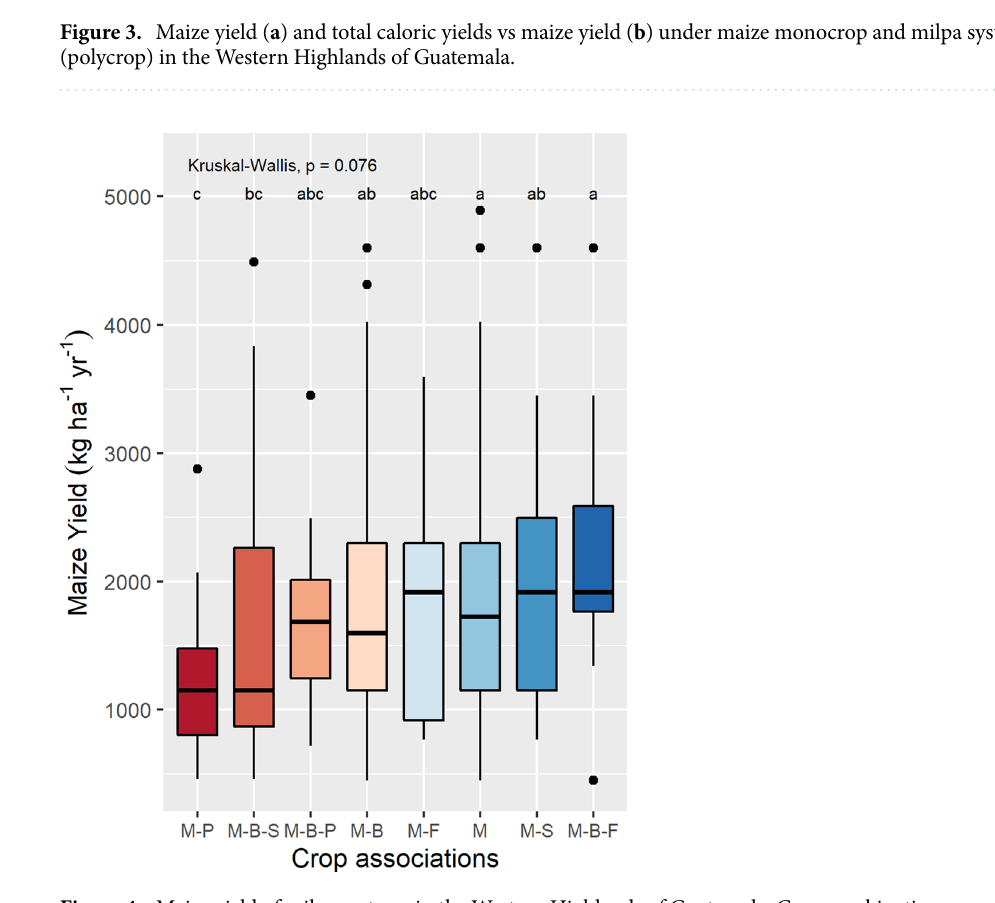
Figure 4. Maize yield of milpa systems in the Western Highlands of Guatemala. Crop combinations are ordered by their mean yield. Significantly different groups after Dunn’s test are indicated with letters within the graphs. Crop associations codes are: M-P: Maize-Potato, M-B-S: Maize-Bean-Squash, M-B-P: Maize-Bean-Potato, M-B: Maize-Bean, M-F: Maize-Faba, M: Maize monocrop, M-S: Maize-Squash, M-B-F: